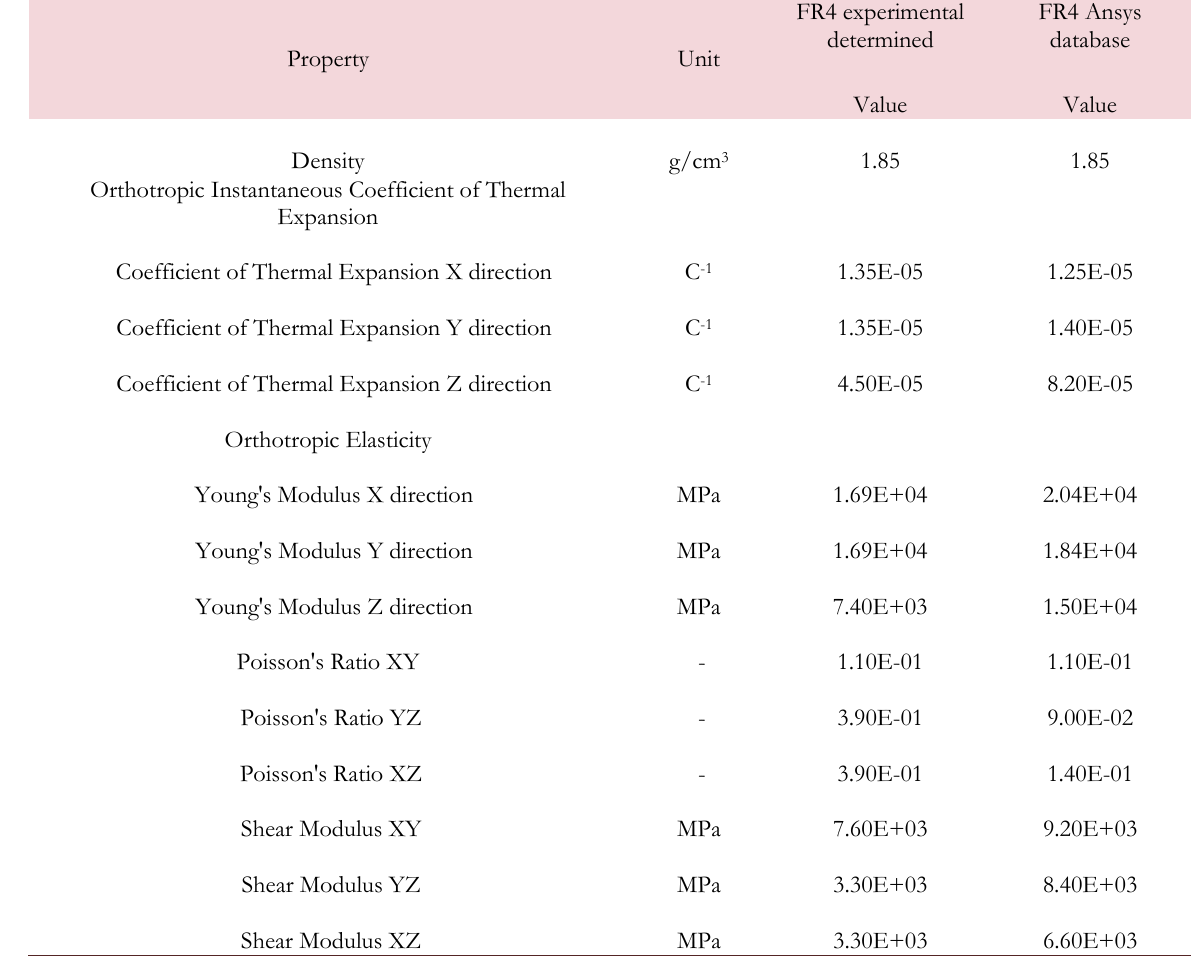
Table 1: Thermomechanical properties of FR4